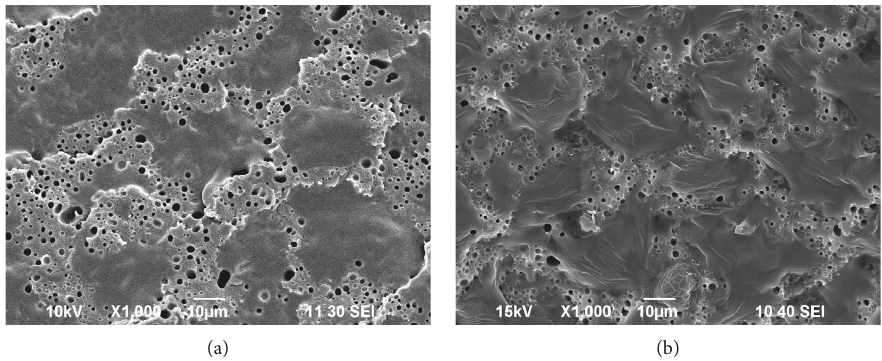
Figure 5: SEM images of PLA/MPLA/TPS (a) and PLA/MPLA/TPS/P (b) blends.